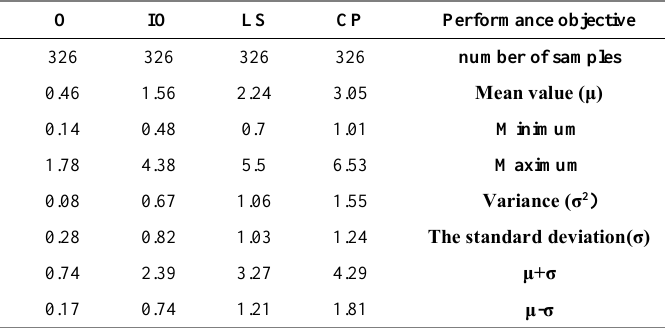
Table 3. Descriptive statistics of specimens’ inter-story